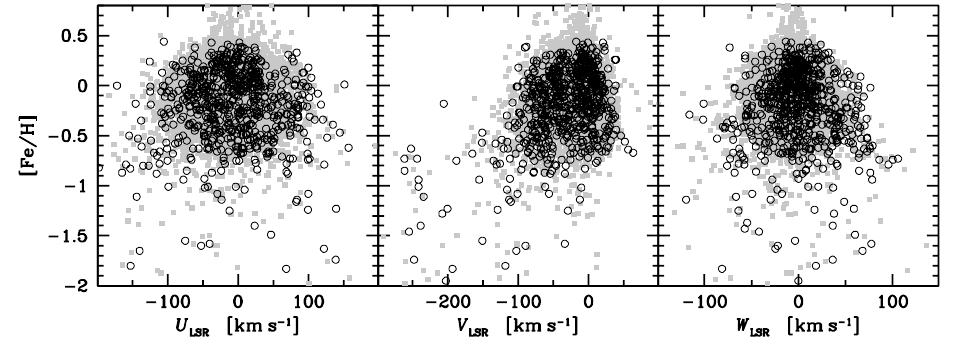
Figure 1. [Fe/H] versus U LSR , V LSR , and W LSR velocities for our stars (o). The grey dots in the background represent the ∼ 14000 stars in the GCS catalogue using the new metallicities from